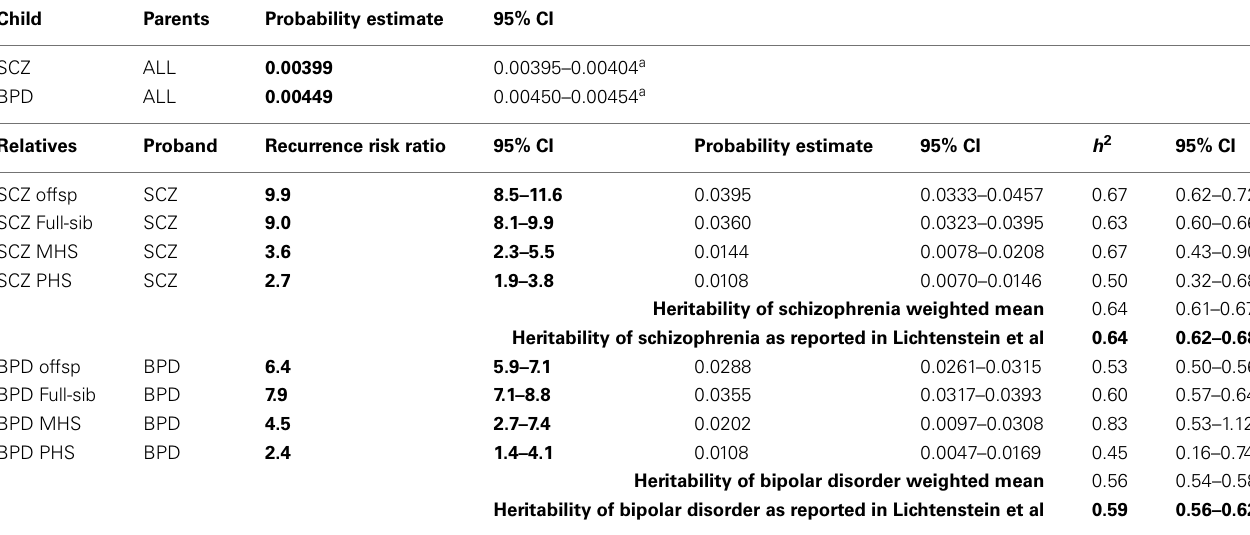
Table 1 |Validation of approach: estimation of heritabilities using probability estimates and recurrence risk ratios presented in Lichtenstein et al.